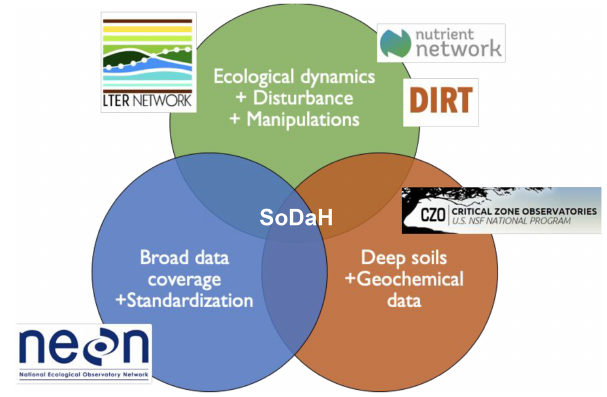
Figure 1. Conceptual diagram that summarizes the strengths and research foci of different experimental networks contributing to So- DaH, modified from Weintraub et al.